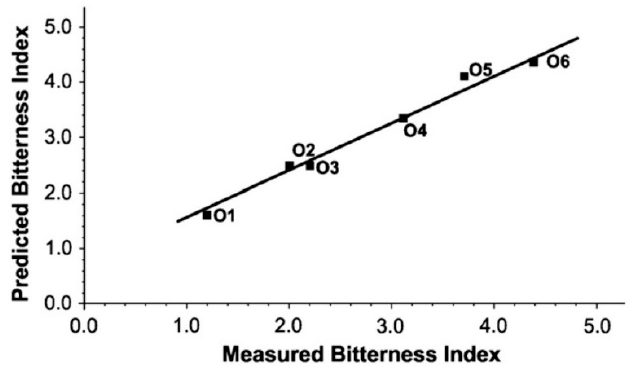
Figure 7. Plot of the bitterness index predicted with the electronic tongue in [65] by means of PLS calibration for different olive oil samples as a function of the corresponding bitterness index obtained by a chemical method. Reproduced with permission.